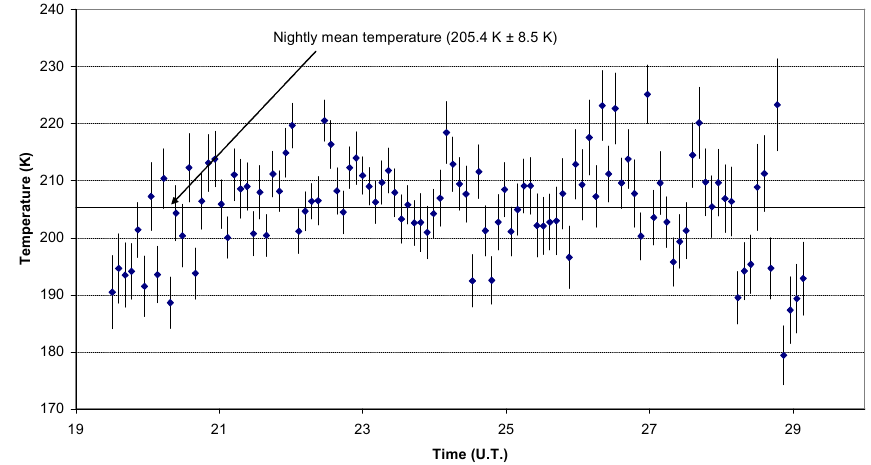
Fig. 1. Rotational temperatures calculated from the OH*(3-1) band recorded at Maynooth (53.2 ◦ N, 6.4 ◦ W) on the night of 16/17 September 1993, which is a representative night from the two-year